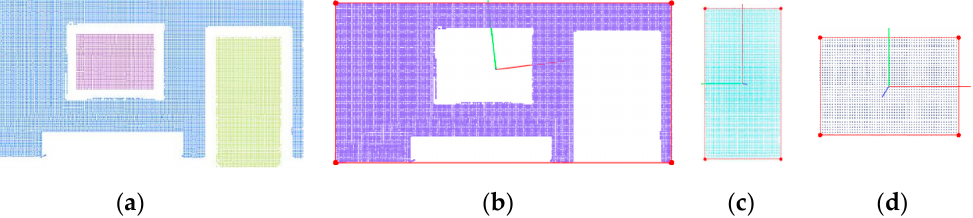
Figure 3. Corner detection result. ( a ) Corner points based on AABB; ( b ) corner points based on OBB.